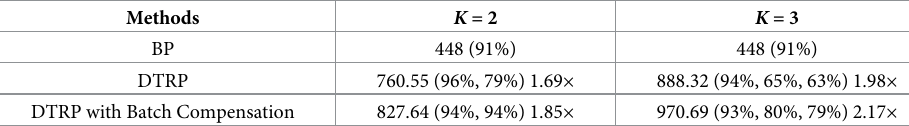
Table 7. Comparison of speed using different